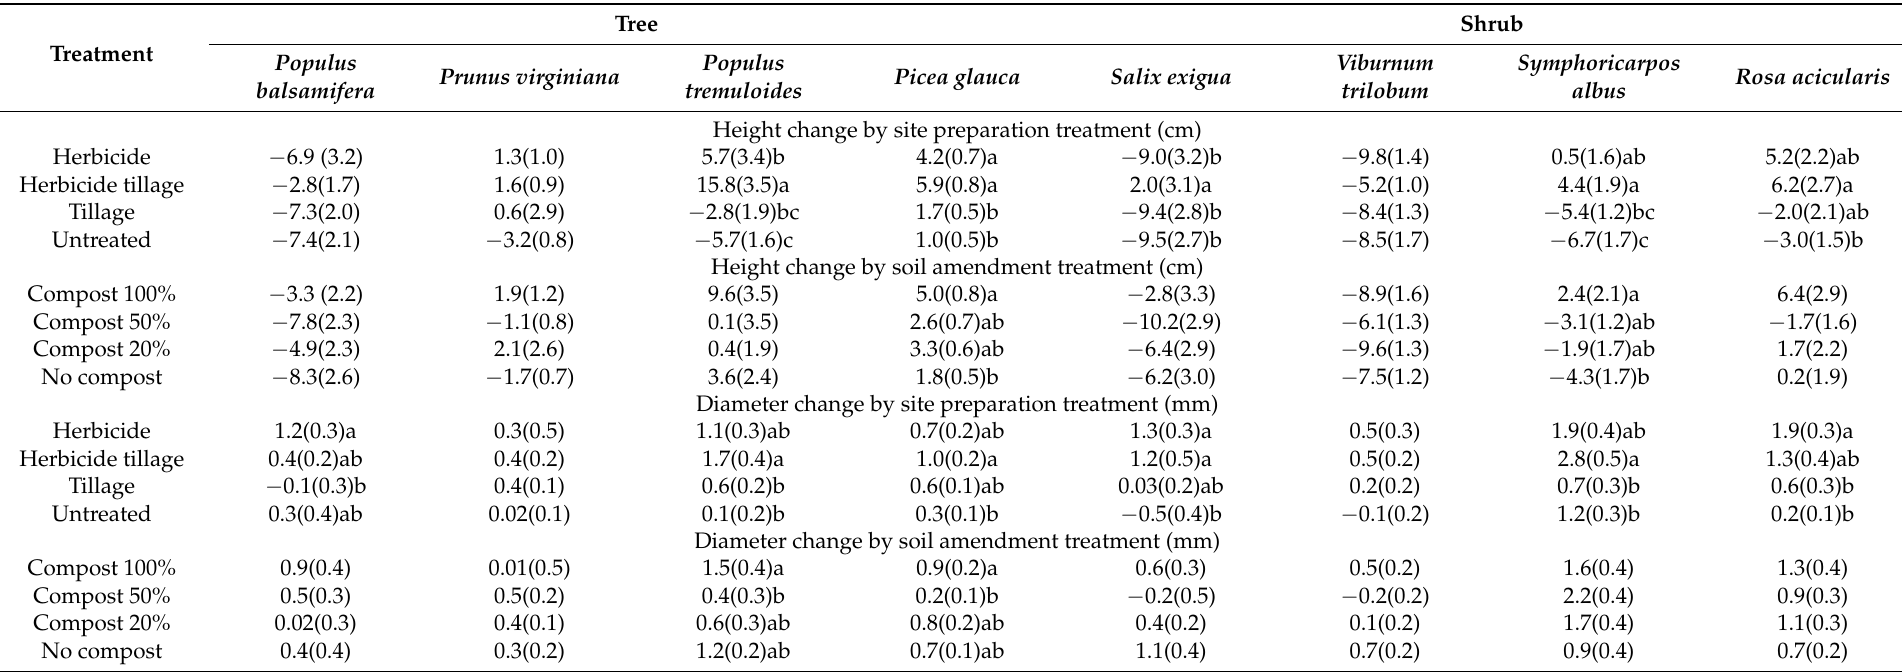
Table 2. Mean height and diameter ( ± SE) change (cm) by site preparation and soil amendment treatments. Different letters within columns indicated significant differences at α =